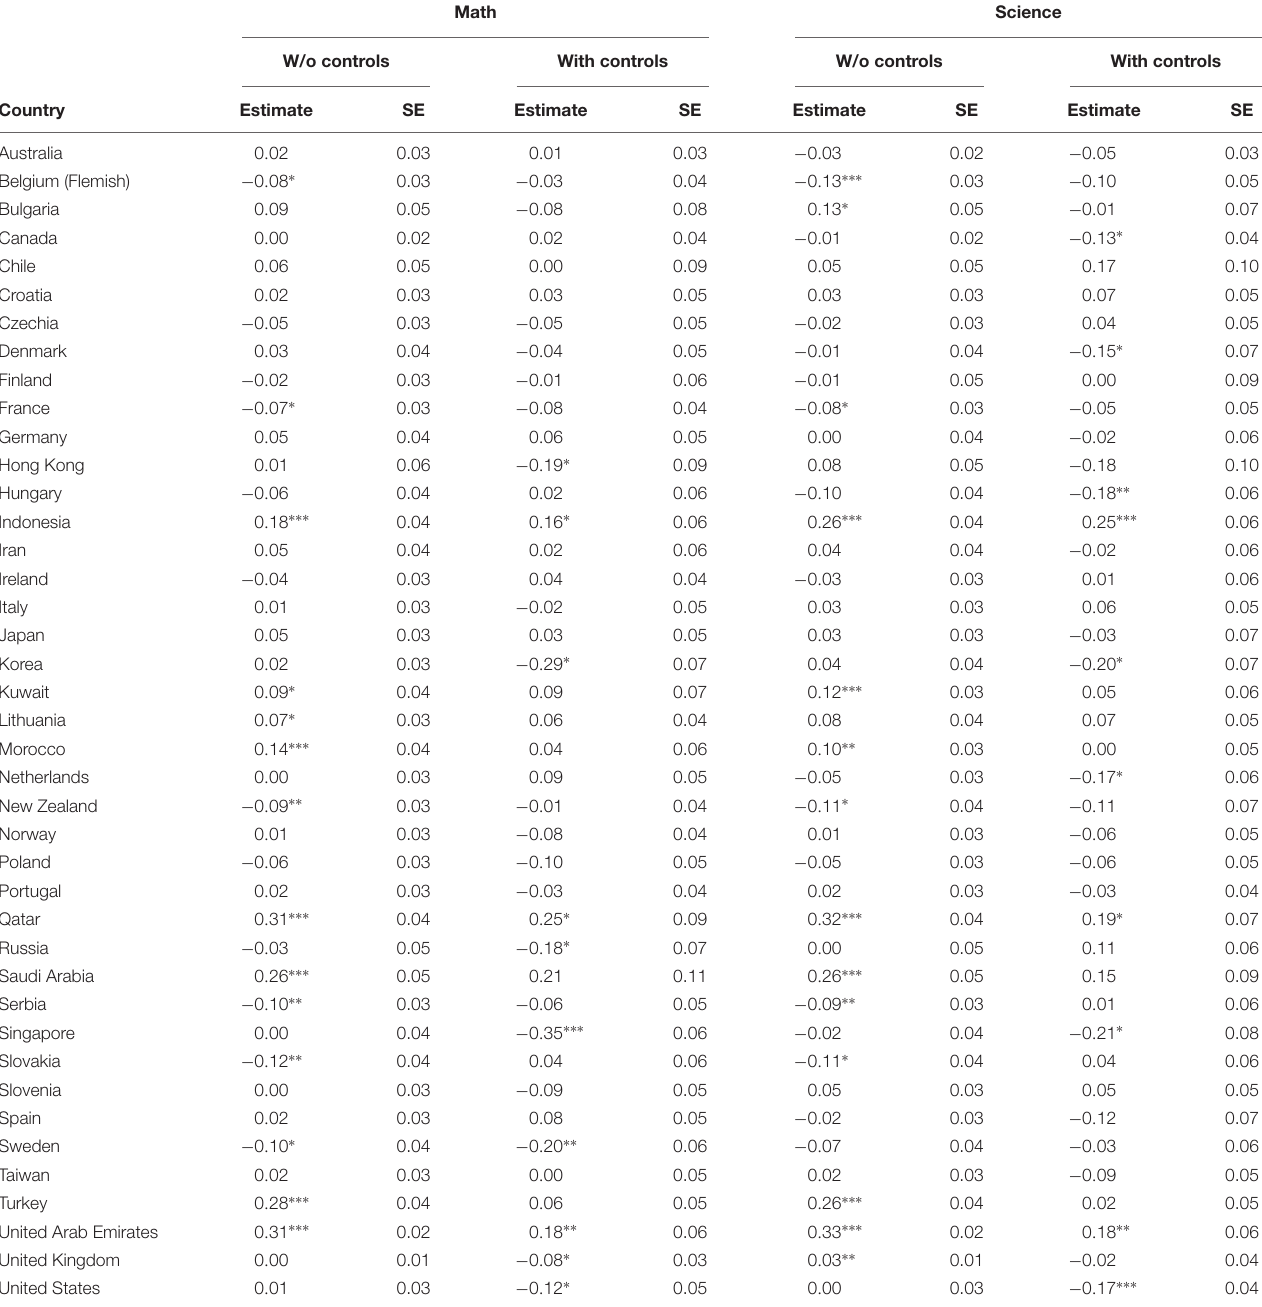
TABLE 3 | Estimates of the MBF effect on achievement in Grade